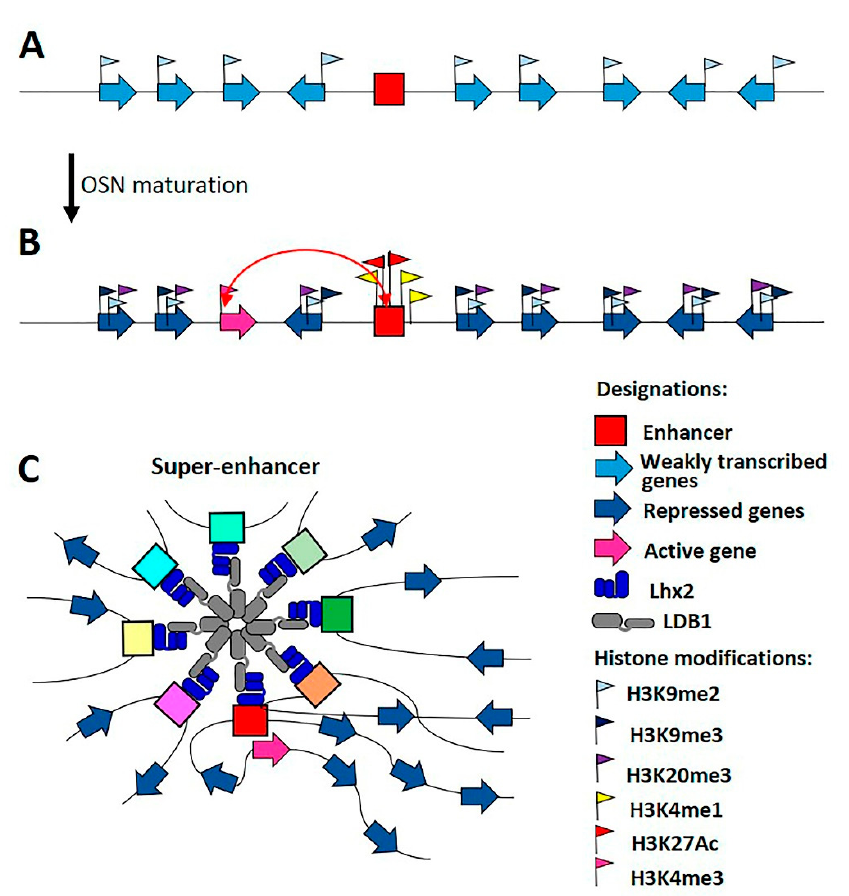
Figure 4. Model of the formation of highly specific transcription hub by OSN enhancers. ( A ) In progenitor cell, all OR genes are weakly co-expressed. ( B ) During OSN maturation, transcription of one OR gene is activated randomly, while all others remain completely suppressed. The OR genes are enriched in chromatin marks (H3K9me3, H3K20me3) associated with transcriptional repression. The transcriptionally active OR promoter, labeled H3K4me3, is associated with a hub formed by enhancers enriched in the Edf and Lhx2 proteins and nucleosomes marked by H3K4me1 and H3K27Ac. ( C ) The LDB1 protein recruited by Lhx2 is involved in the organization of hub formed by OSN enhancers located on different chromosomes. It seems likely that other unknown architectural proteins are involved in hub formation in cooperation with LDB1.